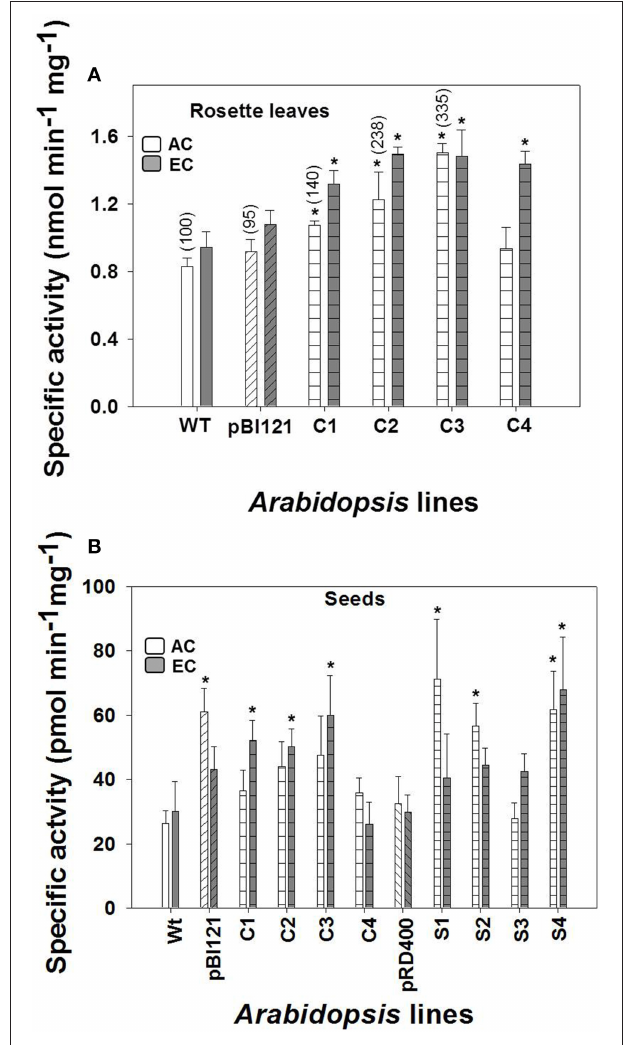
FIGURE 1 | Maximal leaf and seed mtPDH complex activity in Arabidopsis lines grown at either AC or EC. Specific enzyme activity of mtPDH in the rosette leaf of constitutive lines (A) , and specific enzyme activity of mtPDH in seeds at the mid to late maturation phase of development for all lines at AC and EC (B) is presented. Bracketed values in (A) represent relative leaf mtPDH activities given in Zou et al. (1999) determined using isolated mitochondrial preparations for lines grown under AC at 23 ◦ C and assayed at 28 ◦ C. CO 2 treatments: 380 ppm (AC, white bars), 700 ppm (EC, gray bars). Asterisks ( * ) indicate results significantly different from wild-type (WT) at α = 0.05 when compared within each CO 2 treatment. Values represent the mean ± SE; n = 3 − 7 plants per line in (A) , and n = 5 − 8 plants in (B) . To convert the activities in nmol (or pmol) min − 1 mg − 1 protein to nmol min − 1 g − 1 fresh weight to allow a direct comparison of activities, the following conversion factors are used: (1) rosette leaf, 32 × nmol min − 1 mg − 1 protein = nmol min − 1 g − 1 fresh weight; and (2) seed, 0.3 × pmol min − 1 mg − 1 protein = nmol min − 1 g − 1 fresh